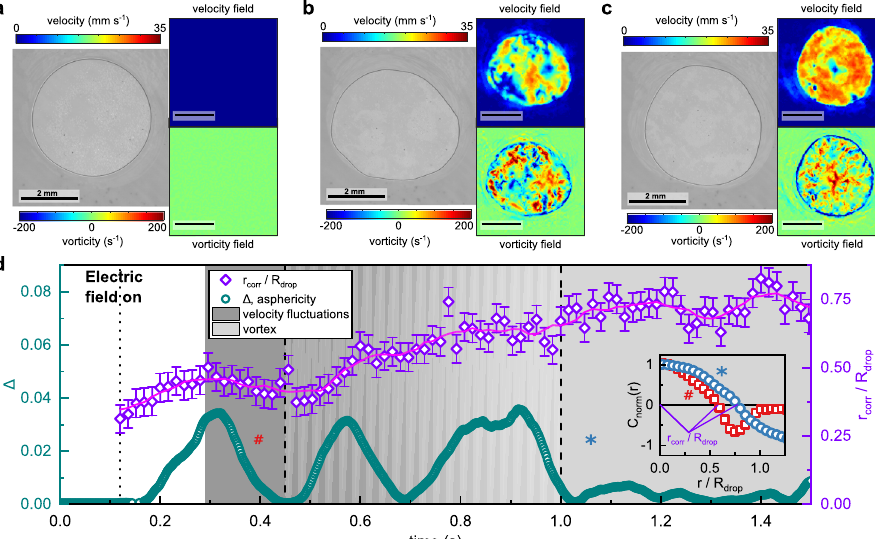
Fig. 2 Shape fl uctuations of a droplet enclosing Quincke rollers. a A droplet in the absence of the electric fi eld, E = 0. b Regime of transient fl ocks and vortices (velocity fl uctuations phase). Rollers velocity and vorticity fi elds in the droplet. Both clockwise (blue) and counter-clockwise (red) vorticity is simultaneously present indicative of transient vortices. Even though the time-variation of the asphericity Δ appears periodic, this behavior is speci fi c for this particular experiment and it is not universally observed. c Globally correlated state (vortex phase). Velocity and vorticity fi elds indicate the presence of a single macroscopic vortex. d Evolution of the droplet shape characterized by the asphericity, Δ (cyan circles, left scale). The right scale presents the time evolution of the correlation length r corr on the same dataset, as de fi ned in the inset from C norm ( r ), the normalized spatial correlation of velocity fi eld, fi rst zero crossing, normalized by the drop radius R drop . The inset shows C norm ( r ) computed from the data in the velocity fl uctuations ( # ) and vortex (*) phases. The dashed lines delineate the regimes of velocity fl uctuations, transition to vortex, and developed vortex. The error bars are the standard error of the mean and the purple line is a running average of the data points to guide the eye. When error bars are not visible they are smaller than the symbols. Experimental parameters: rollers packing fraction φ = 0.18 ± 0.04, droplet area A drop = 13.56 ± 0.03 mm 2 and electric fi eld strength E = 5.104 ± 0.008MV m − 1